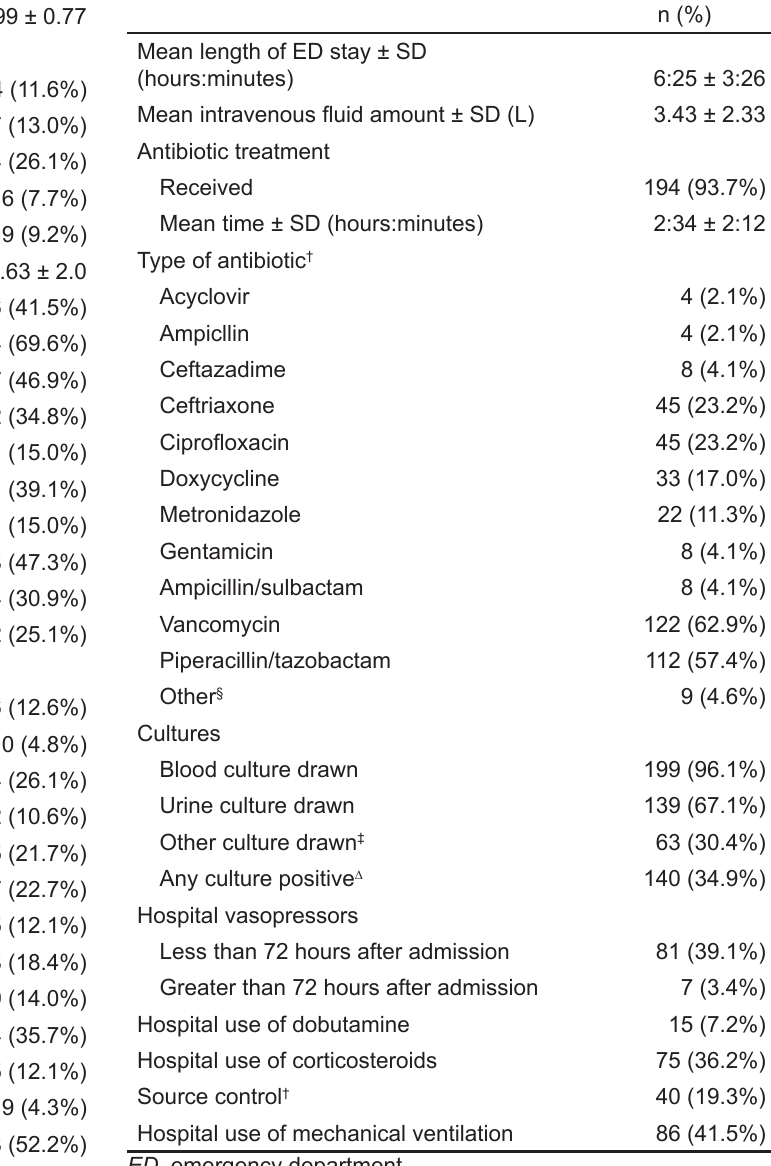
Table 2. Interventions and treatment